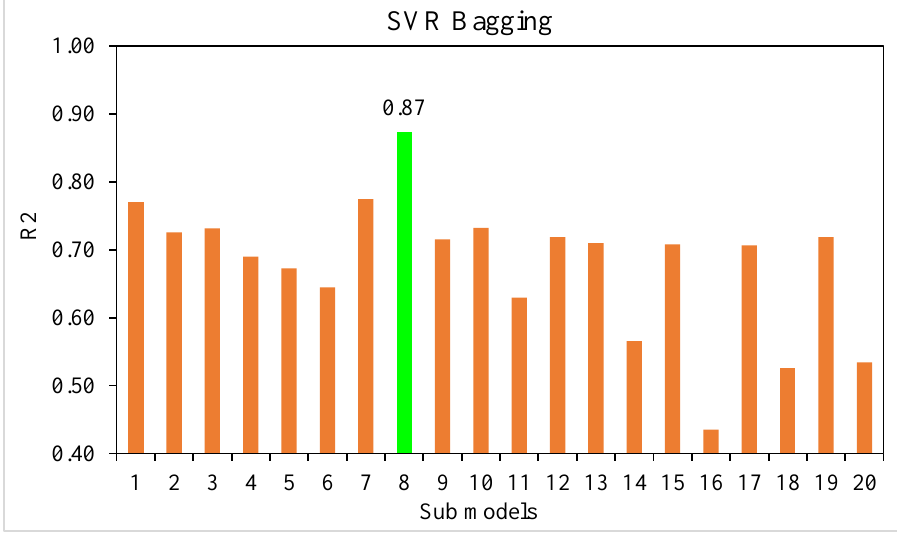
Figure 14. SVR bagging sub-model’s coefficient of correlation (R 2 ) values.